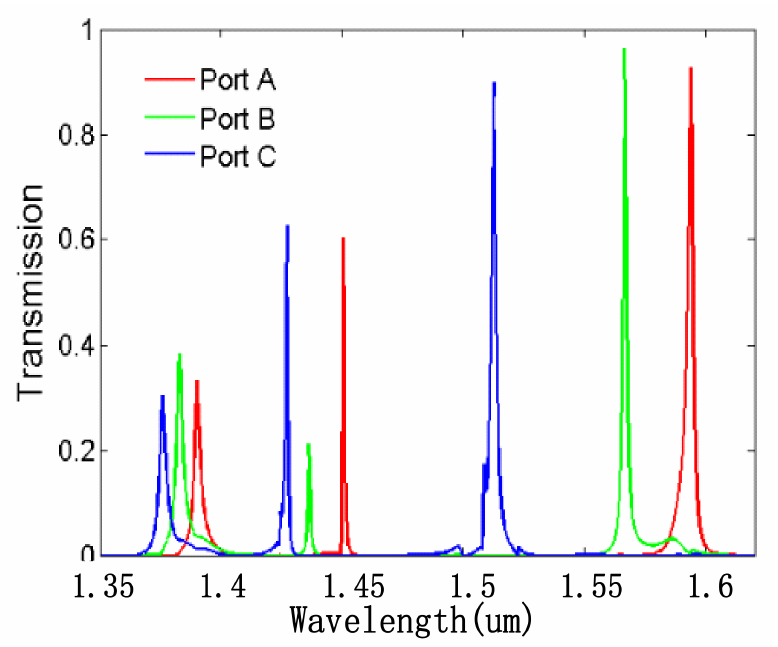
Figure 3. Transmission spectrum of the photonic crystal filter.